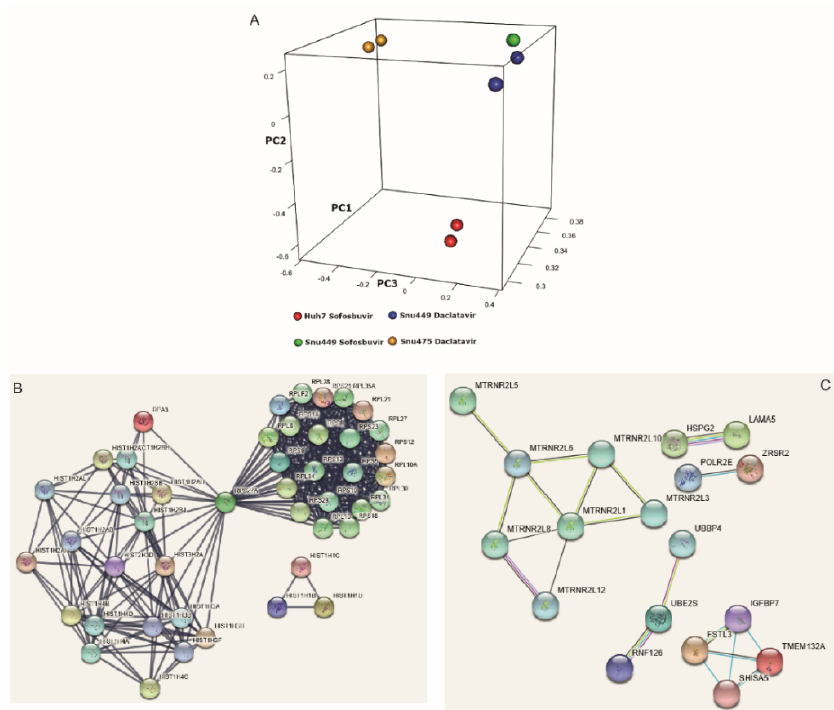
Figure 3. Effects of DAAs on gene expression of HCC-derived cell lines. ( A ) 3D projection of principal component analysis. Separation between different cell lines is visible on both second and third components. ( B ) STRING analysis of commonly downregulated genes in SNU449 and Huh7 treated by sofosbuvir evidenced two major interaction networks: histone- and ribosomal protein-coding genes. ( C ) STRING analysis of genes downregulated by sofosbuvir and upregulated by daclatasvir in SNU449 cells.